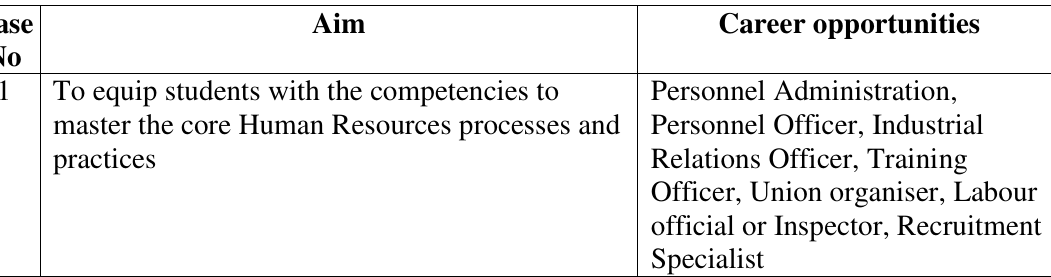
Table 1: A compilation of the extracts of the web page information of some of the departments that teach Human Resources Management and Industrial